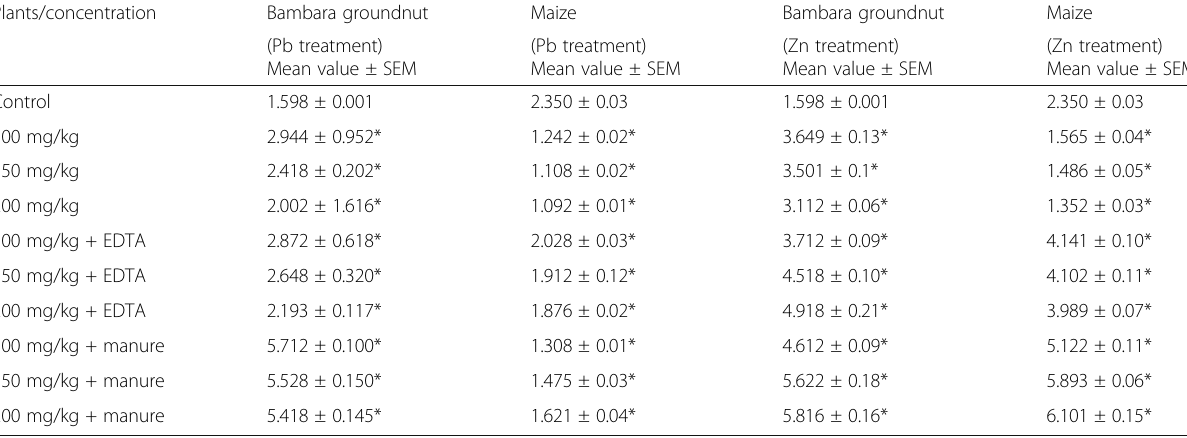
Table 3 Impact of lead concentrations on total chlorophyll (mg/g) of the test plants